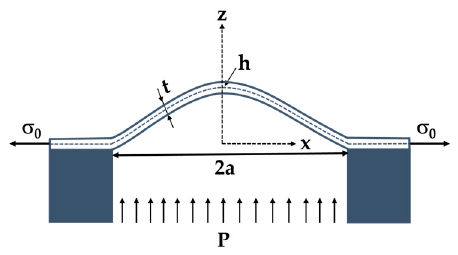
Figure 2. Schematic cross-sectional membrane with initial in-plane tension under uniform pressure P .